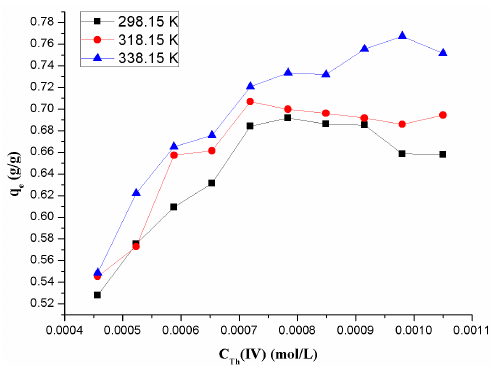
Figure 11. Effect of temperature on the adsorption of Th(IV) onto β -CD(AN- co -AA).